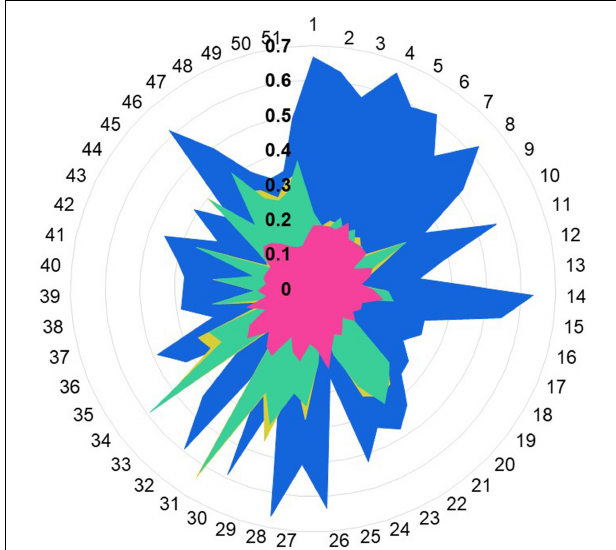
FIGURE 5 | Ligand profile for OR1A1 and selected templates. The similarity of OR1A1 ligands with: retinal (from 1U19) is represented in blue color, netupitant (from 6HLP) is in gold color, ramatroban (from 6IIU) is represented in green color, and ITD (from is represented in pink color). OR1A1 ligands from 1 to 51 are listed in Supplementary Table 4 . Tanimoto scores between OR1A1 ligands and the template ligands range from 0.1 to 0.7 (in